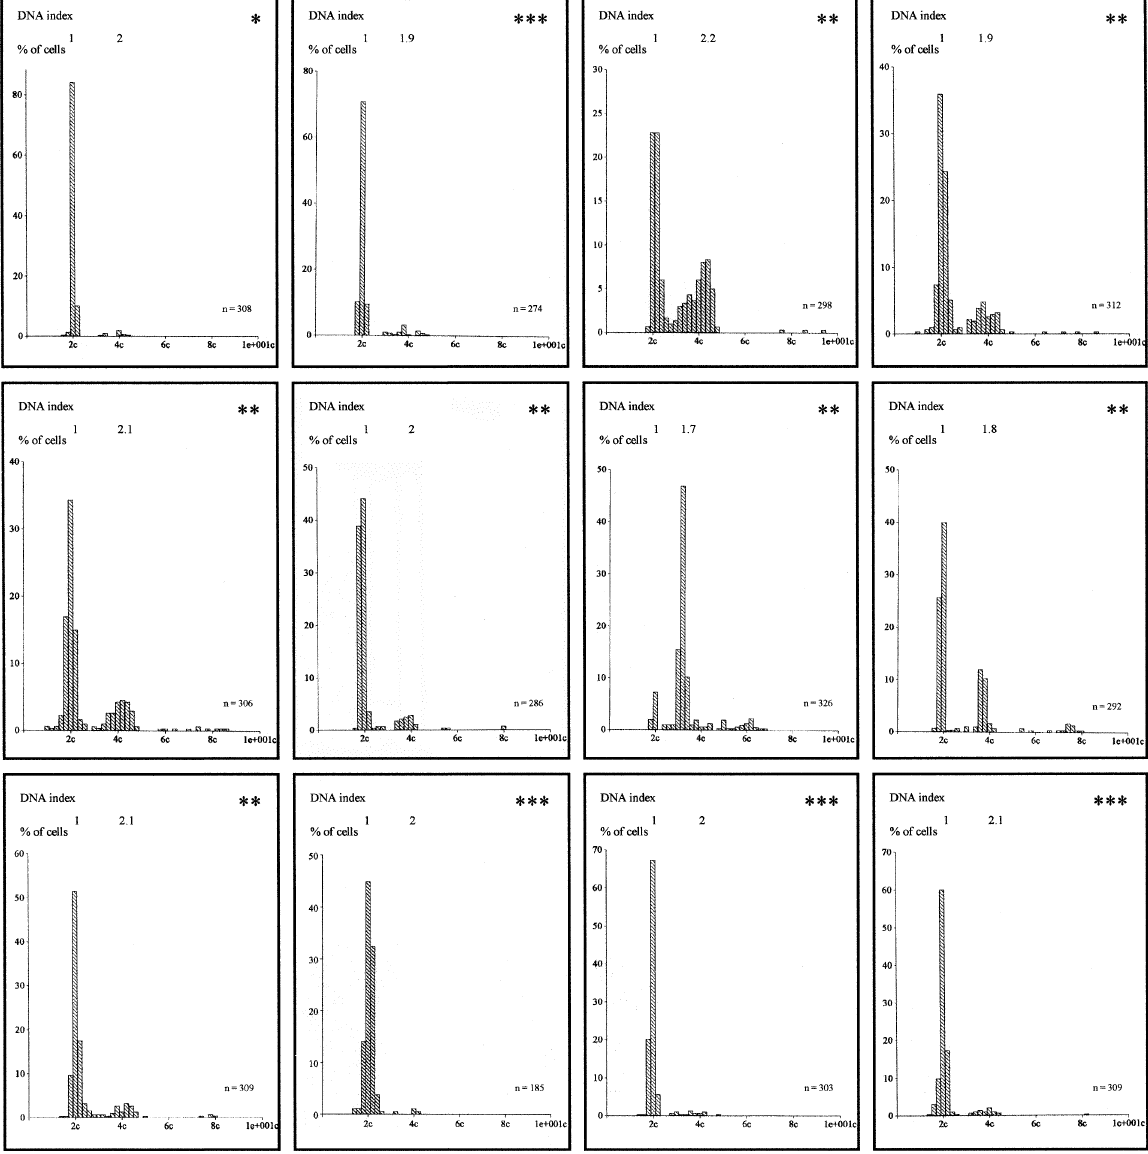
Fig. 3. Histograms illustrating a DNA-ploidy heterogeneous gastric carcinoma: ∗ normal mucosa (diploid), ∗∗ tumoral sample showing an aneu- ploid histogram, ∗∗∗ tumoral sample showing a diploid histogram. n = number of cells